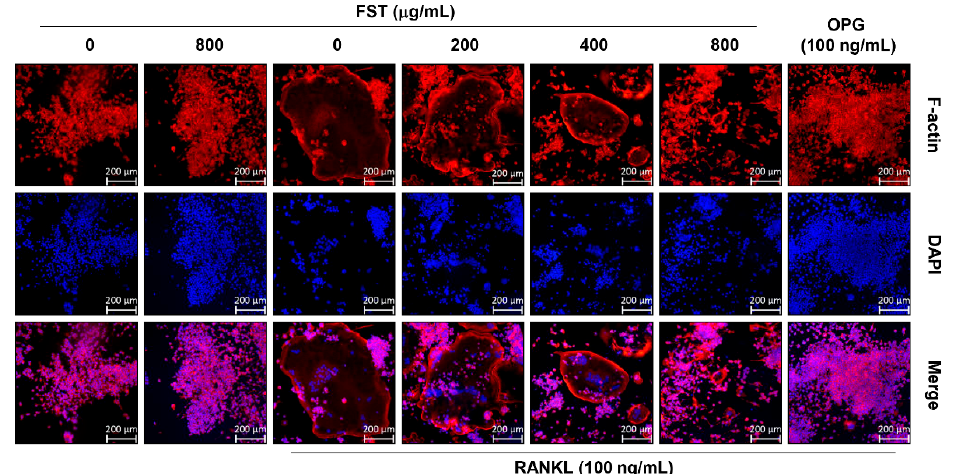
untreated the reagent.